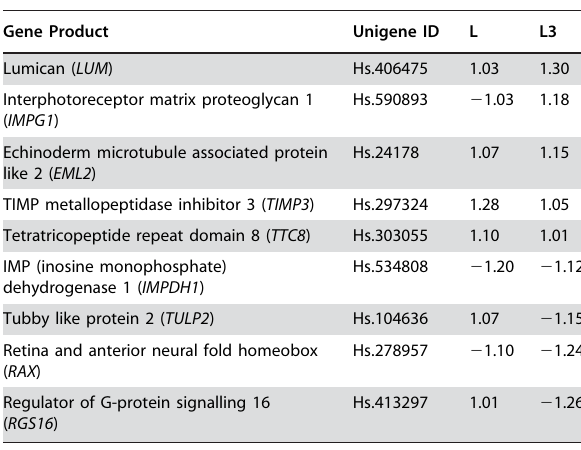
Table 3. Visual perception gene fold-changes in